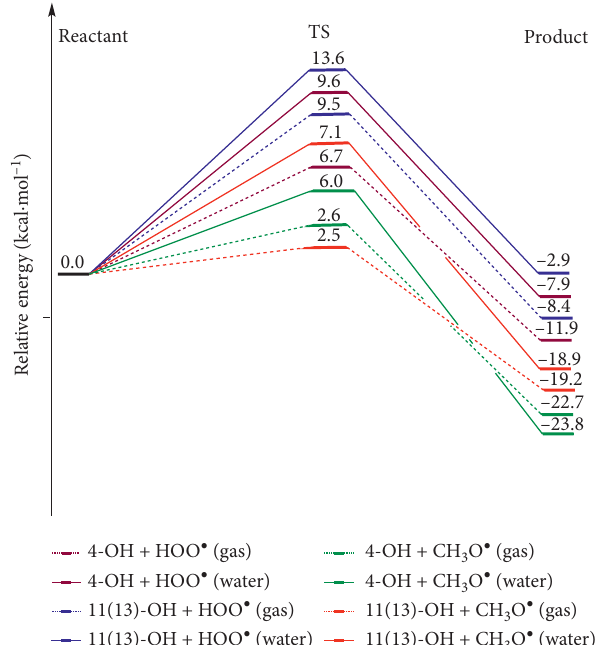
Figure 7: Energy diagram for HOO • and CH3O • radical attack on hydroxy groups of RSV at B3LYP/6-311++G(d, p) level of theory.